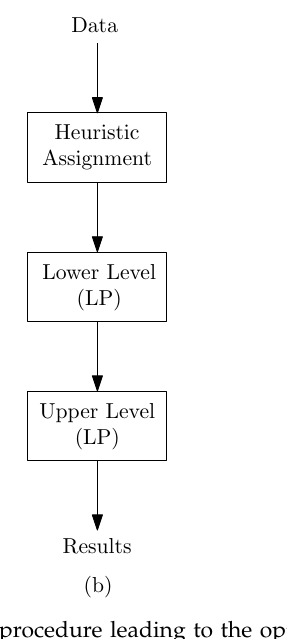
Figure 2. ( a ) Flow chart of the procedure leading to the optimal solution. ( b ) Flow chart of the proposed heuristic